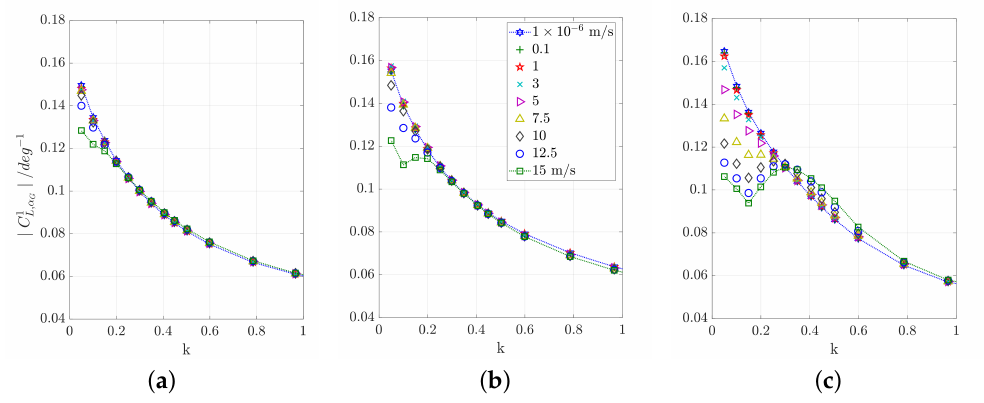
Figure 9. Magnitude of lift first harmonic. ( a ) Mach 0.66, ( b ) Mach 0.68, ( c ) Mach